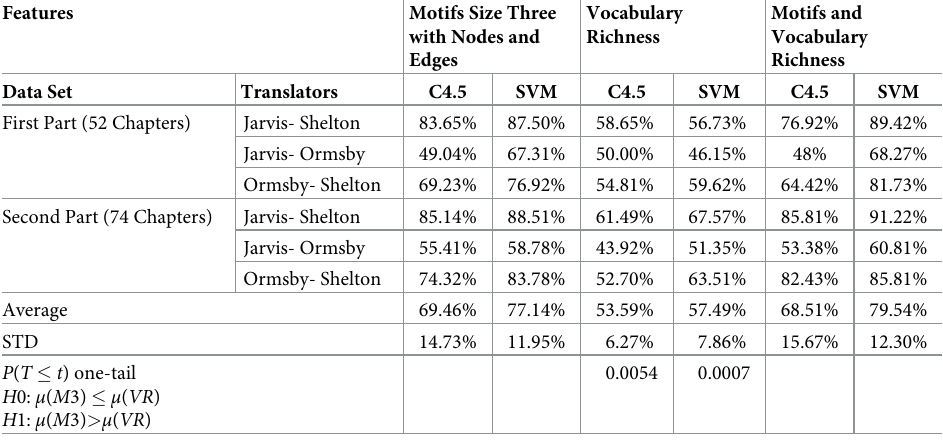
Table 10. Classification results for motifs of size three and vocabulary richness as translator stylometry features for the 2nd corpus.